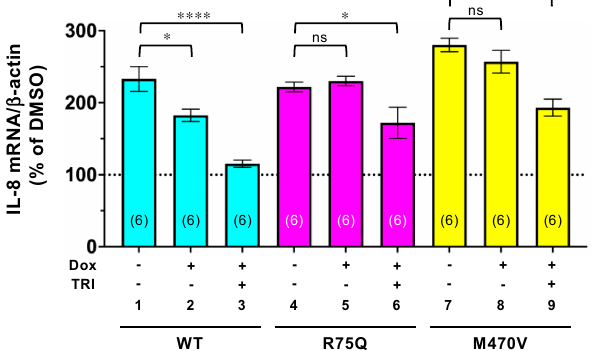
Figure 8. Trikafta suppresses the PYO-induced IL-8 expression in CFBE Tet-on cells. CFBE Tet-on cells expressing WT-, R75Q, or M470V-CFTR were treated with or without Dox (1 µg/ml) for 3 days. PYO (5 µM) and Trikafta (3 µM VX-661, 3 µM VX-445, and 1 µM VX-770) were treated for 24 hours before analysis. PYO-induced IL-8 mRNA expression was quantified by RT-qPCR. Data represent mean±SE. The number of data from at least two independent experiments is indicated in parentheses. n.s., not significant; * p < 0.05, ** p < 0.01, *** p < 0.001, **** p < 0.0001 vs. nontreated cells (one-way ANOVA).